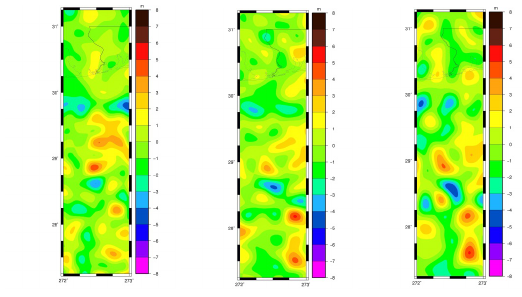
Figure 4. Gravity differences along the tracks T108 and T811.